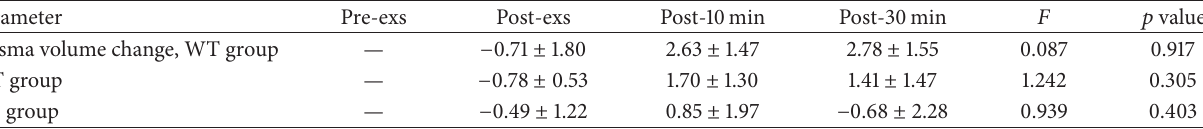
Table 2: Estimated percentage of changes in plasma volume in the groups of WT, MT, and